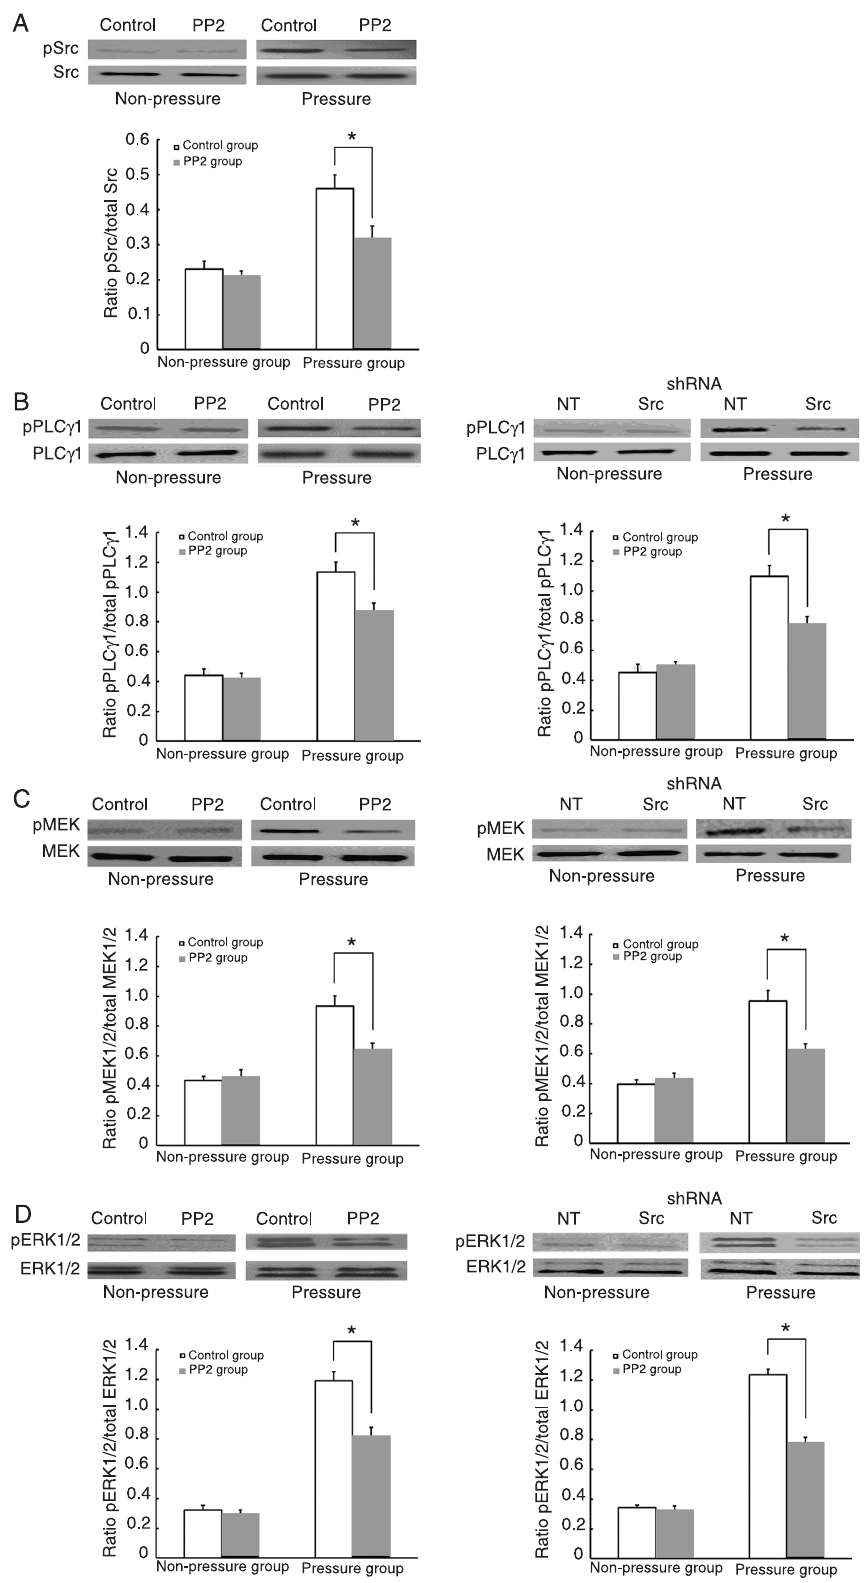
Figure 6. Effect of PP2 and Src shRNA on the expression and phosphorylation of Src, PLCγ1, MEK1/2, and ERK1/2 under con- ditions of periodic mechanical stress. After pretreatment with DMSO or Src inhibitor (PP2), or Src shRNA or non-targeting (NT) sequence, rat chondrocytes were cultured in vitro for 1 h under static conditions or conditions of period- ic mechanical stress. The expres- sion and phosphorylation levels of Src ( A ), PLCγ1 ( B ), MEK1/2 ( C ), and ERK1/2 ( D ) were detected by Western blotting. For each West- ern blot, the corresponding total amount of each signaling protein served as a control. The images above the histogram are repre- sentative results of several inde- pendent Western blots. The phos- phorylation levels of Src-Tyr 418 in the PP2 groups were significantly reduced compared to those in the control groups in chondrocytes in response to periodic mechanical stress (N = 5, *P < 0.05, Student unpaired t -test). The phospho- rylation levels of PLCγ1-Tyr 783 , MEK-Ser 217/221 and ERK1/2- Thr 202 /Tyr 204 in the PP2 and Src shRNA groups were significantly reduced compared to those in the control groups in chondrocytes in response to periodic mechanical stress (N = 5, *P < 0.05, Student unpaired t